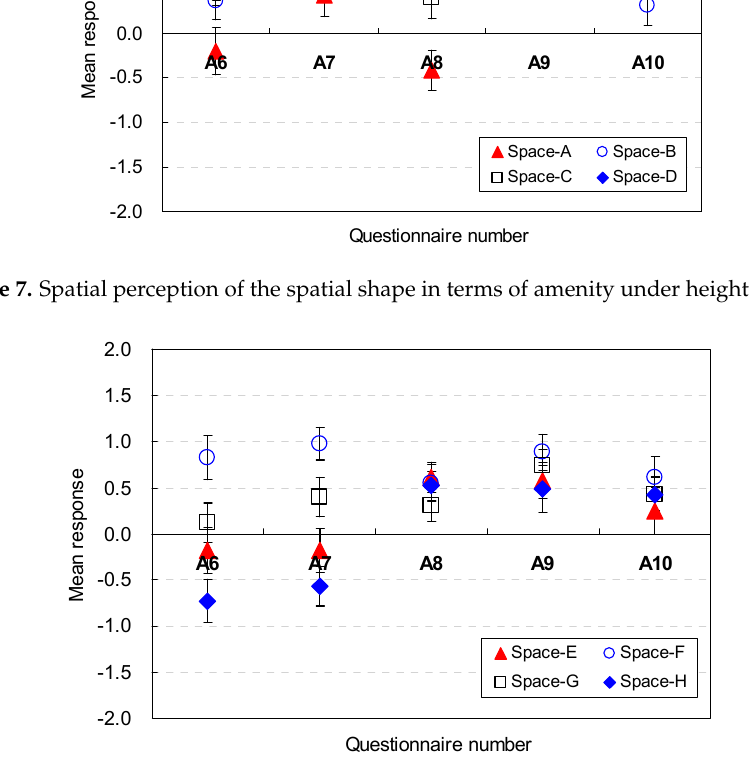
Figure 8. Spatial perception of the spatial shape in terms of amenity under floor layout changes.